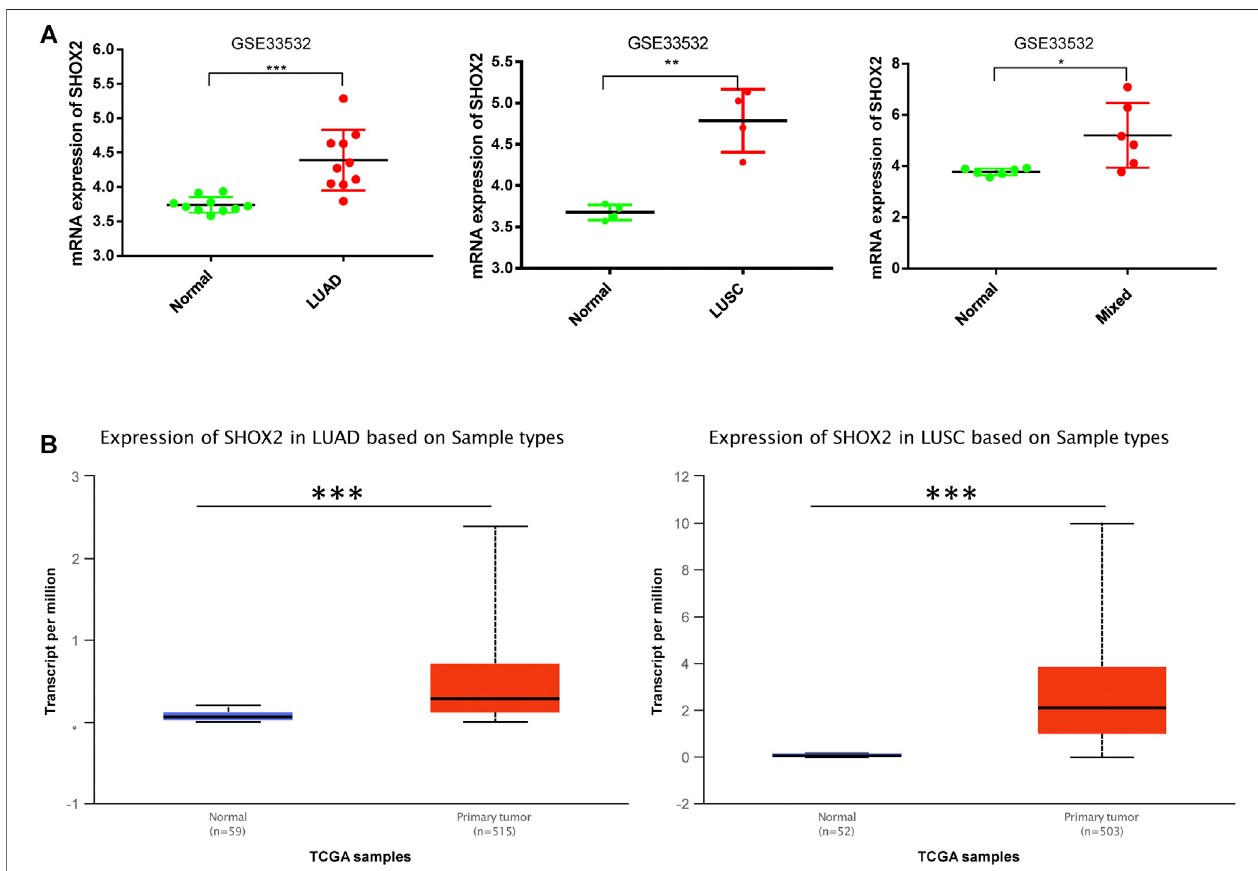
FIGURE 2 | Box plot showing the relative expression of SHOX2 in normal and NSCLC samples. (A) SHOX2 expression is shown by microarray analysis of 20 NSCLC patients in GSE33532 including 10 LUAD patients, 4 LUSC patients, and 6 mixed patients. These data are compared with those of paired normal tissues. The data are addressed by GraphPad Prism 7.0 and applied paired t -test. (B) The expression levels of SHOX2 between normal and LUAD or LUSC tissues are shown in the box plot by UALCAN online analysis tool application. *** represents p < 0.001 (highly signi fi cant); ** represents p < 0.01 (very signi fi cant); * represents p < 0.05 (signi fi cant); LUAD: lung adenocarcinoma; LUSC: lung squamous carcinoma; NSCLC: non-small-cell lung